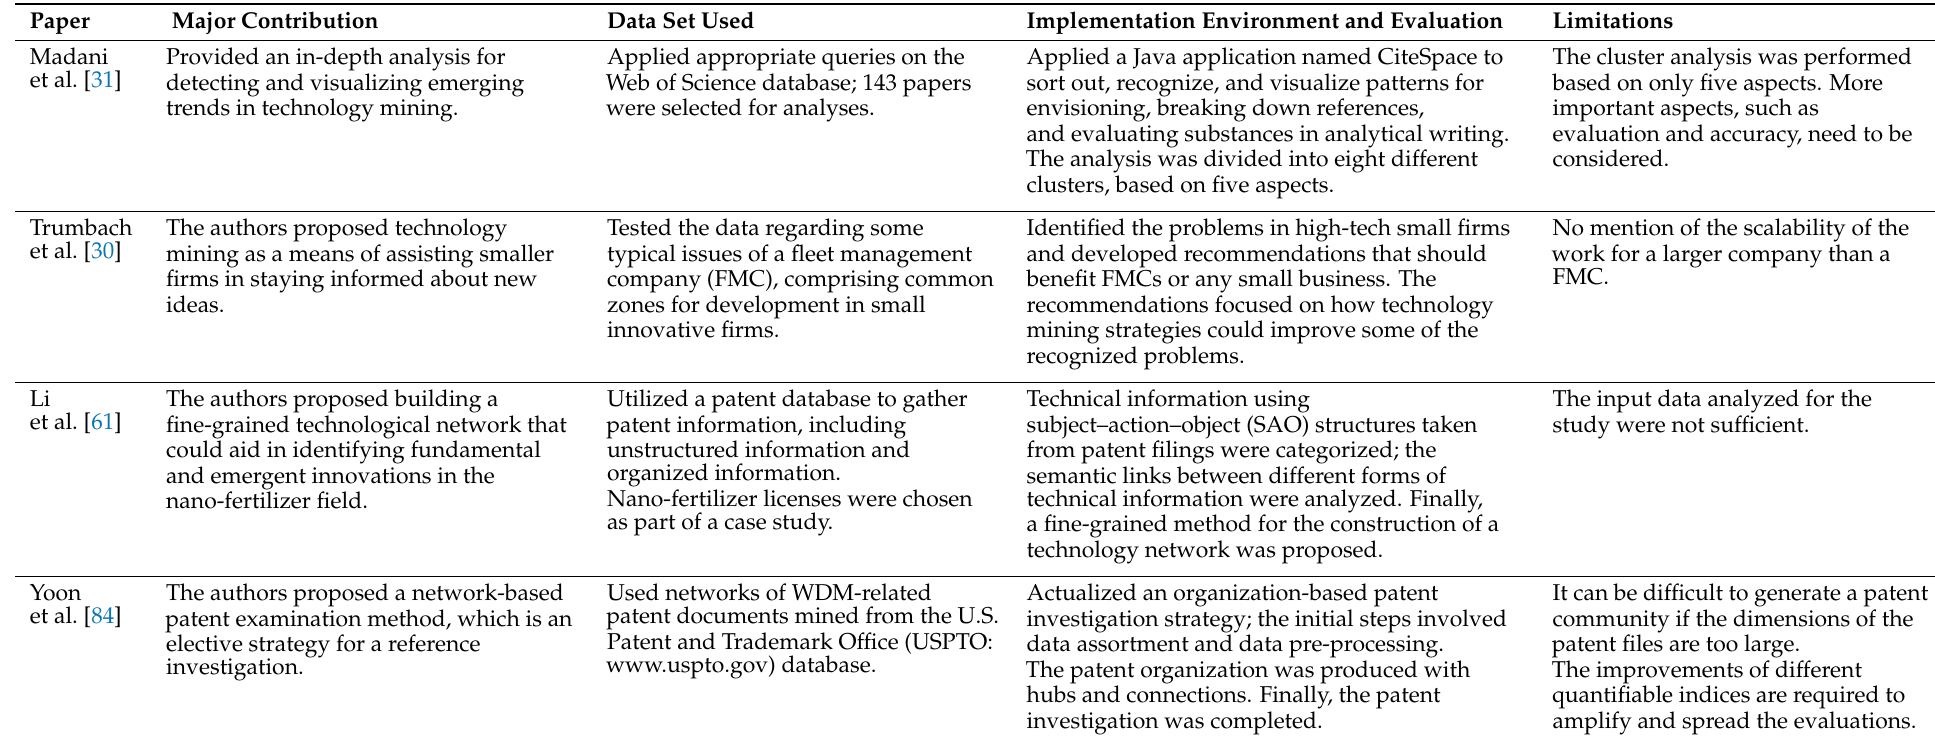
Table 5. Summary of the research on technology